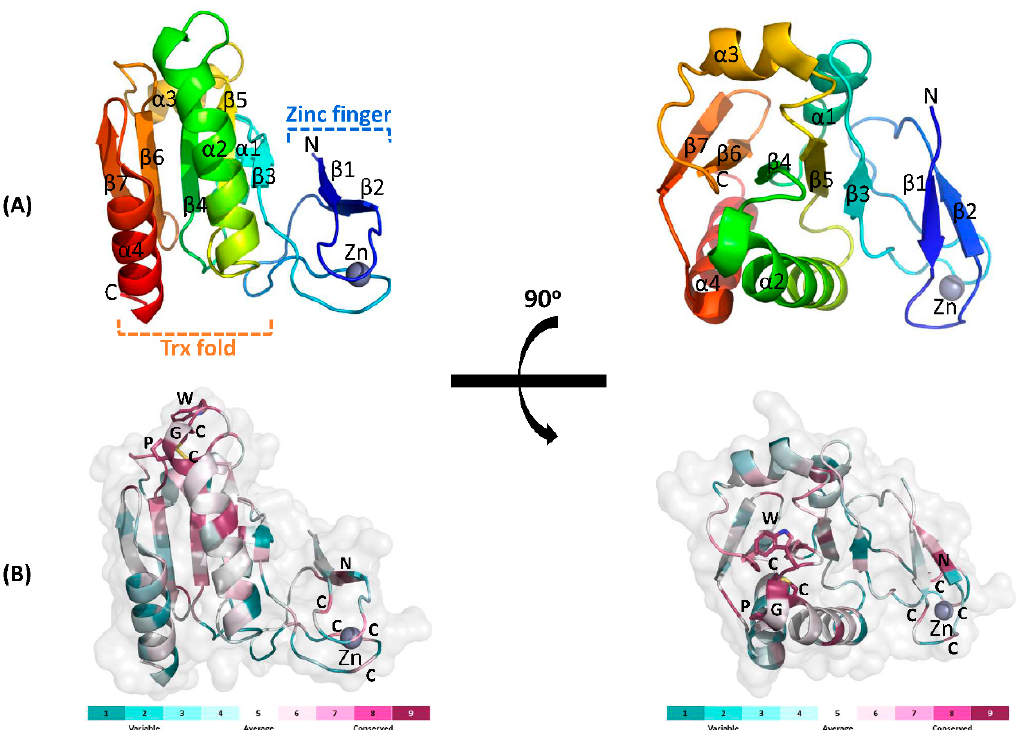
Figure 4. Overall structure of DrTrx2. ( A ) Cartoon representation of the full-length structure of DrTrx2. The molecule is colored progressively, from blue at the N-terminus to red at the C-terminus. The four α -helices ( α 1- α 4) and seven β -sheets ( β 1– β 7) are labelled. One zinc ion bound to the N-terminal zinc-finger domain is shown as a gray sphere. ( B ) Surface conservation of the DrTrx2. The sequence conservation pattern of DrTrx2 was obtained using the Consurf server. Cartoon representation of DrTrx2 shown at the same orientation as ( A ) with a transparent surface. Residues are colored from magenta to cyan with a descending order of conservation, as shown in the color-coding bar below. The active site WCGPC motif, the zinc binding cysteines, and a zinc ion are labelled.